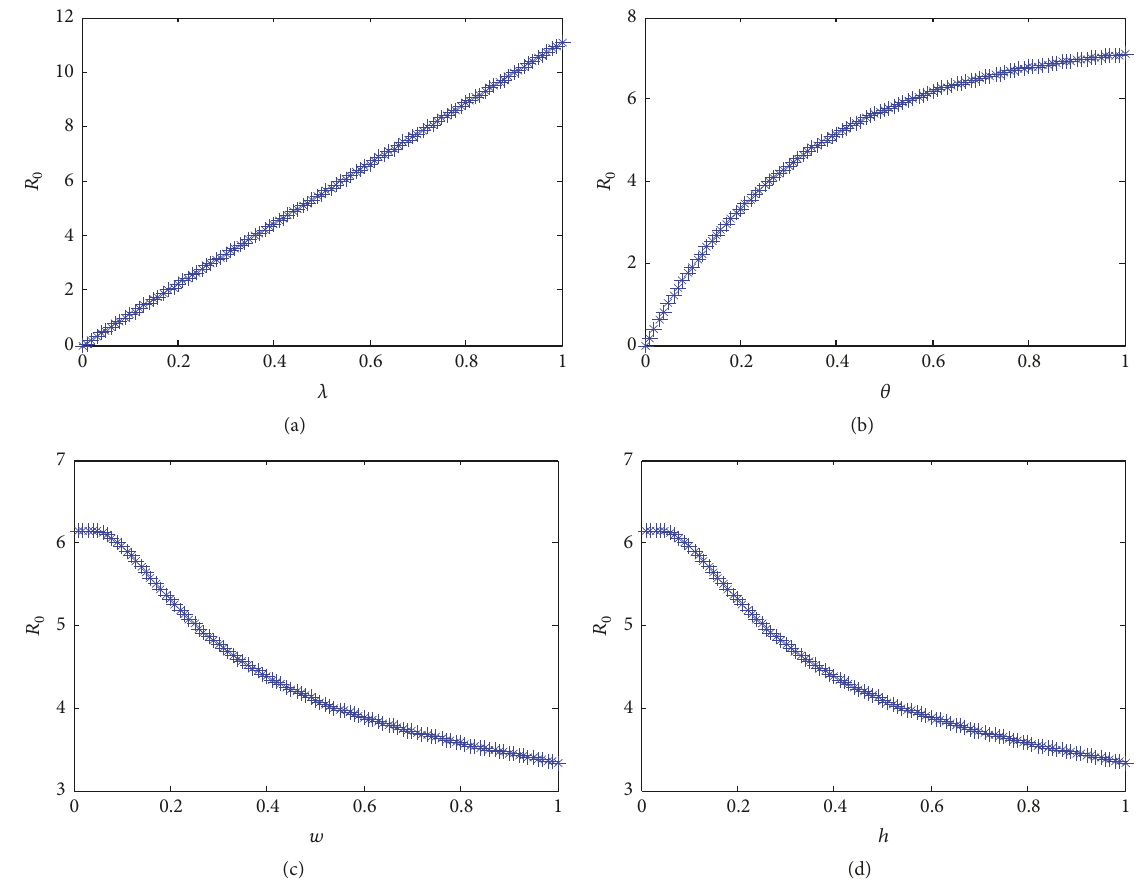
Figure 4: Effect of information transparency on the evolution characteristics of food safety scare behavior diffusion: (a) the effect of the rate of information dissemination 𝜆 on the evolution characteristics of food safety scare behavior diffusion; (b) the effect of consumer concerns about food safety incidents 𝜃 on the evolution characteristics of food safety scare behavior diffusion; (c) the effect of government food safety supervision information transparency 𝑤 on the evolution characteristics of food safety scare behavior diffusion; and (d) the effect of media food safety supervision information transparency ℎ on the evolution characteristics of food safety scare behavior